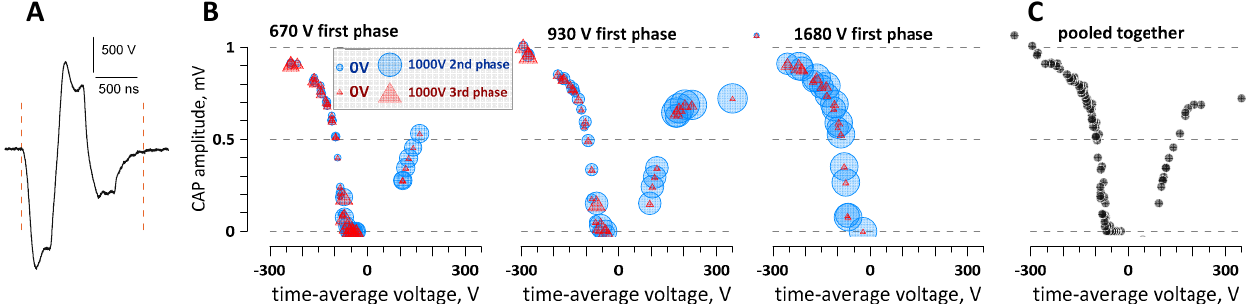
Figure 4. The time-average voltage measured across a triphasic stimulation pulse determines the amplitude of the evoked compound action potential (CAP). The data are from one representative experiment using a triphasic pulse ( A ) with adjustable amplitudes of each phase. The stimulating voltage was automatically averaged across the interval between the vertical dashed lines and used for abscissa values in ( B , C ). The vertical scale in ( B , C ) is the elicited CAP amplitude. The three panels in ( B ) are for three discrete amplitude values of the 1st (cathodic) phase of the pulse, as shown in the legends. The amplitudes of the 2nd and the 3rd phases are coded by the symbol size, with the legend and symbol size scaling shown in the left panel. ( C ) All the datapoints pooled together and plotted irrespective of the individual phase